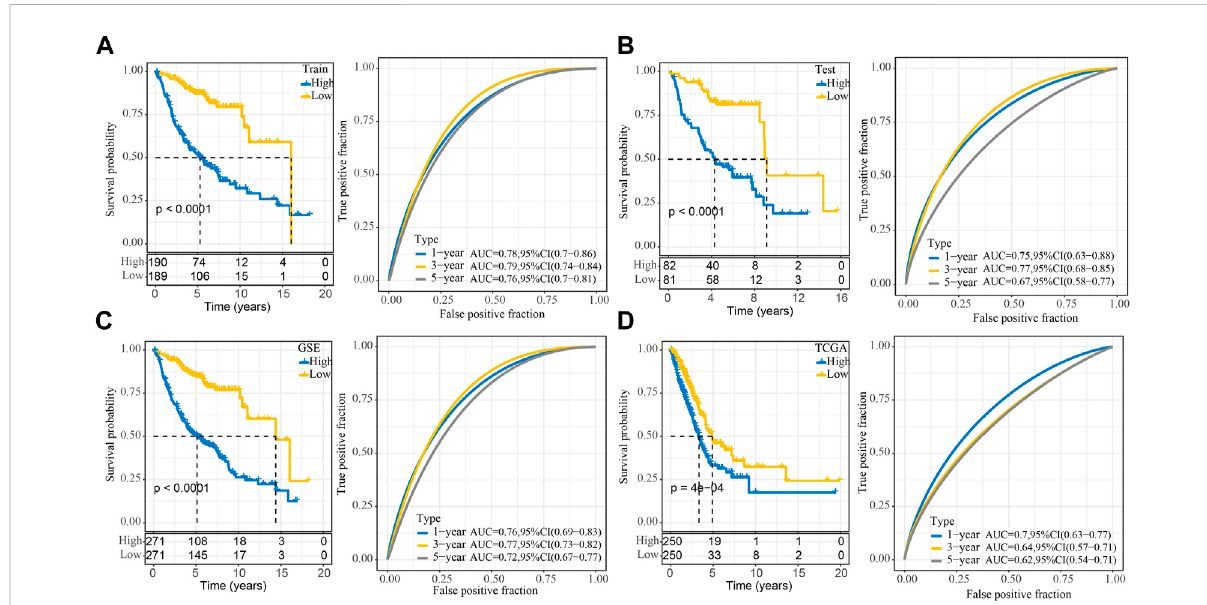
FIGURE 5 Stability ofthe RiskScore prognostic model for differentdatasets. (A) ROC and KM survival curves for RiskScore in theGEO training data cohort; (B) ROC and KMsurvival curves for RiskScore intheGEO validation data cohort; (C) ROC andKMsurvivalcurves for RiskScoreintheGEO cohort and KM survival curves in the GEO cohort; (D) ROC and KM survival curves for RiskScore in the TCGA